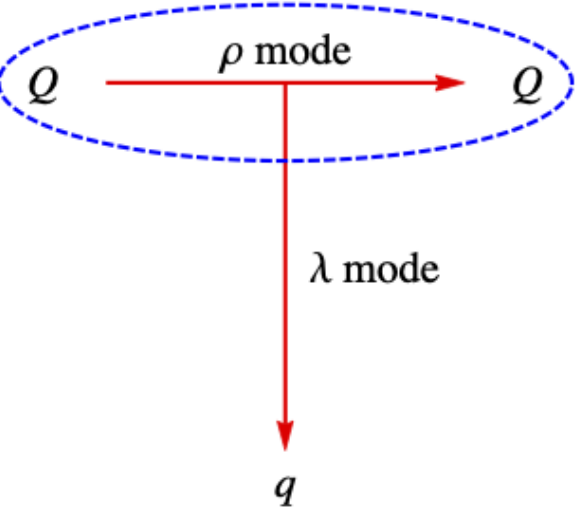
Figure 1. Doubly heavy baryon system with Jacobi coordinates ρ and λ